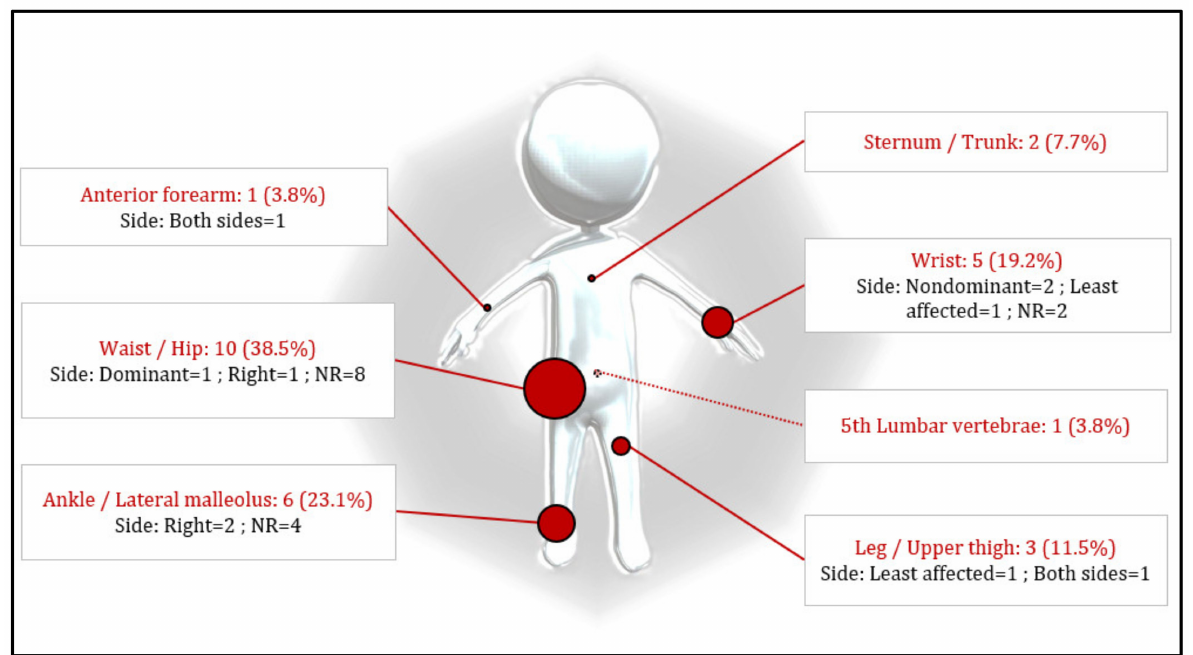
Figure 7. Location and percentage of devices according to method